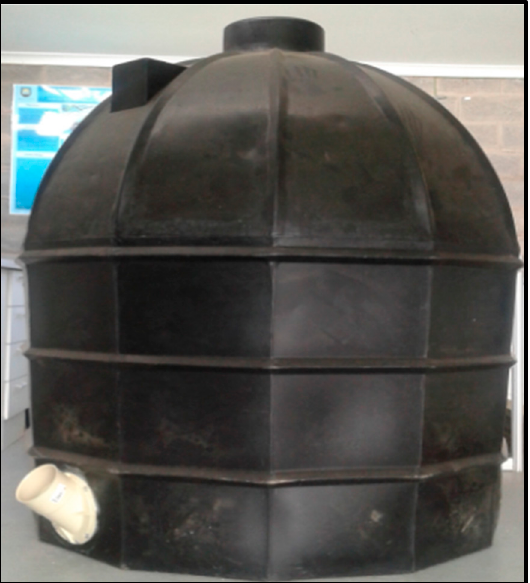
Figure 1. Fabricated high-density polyethylene biogas digester.